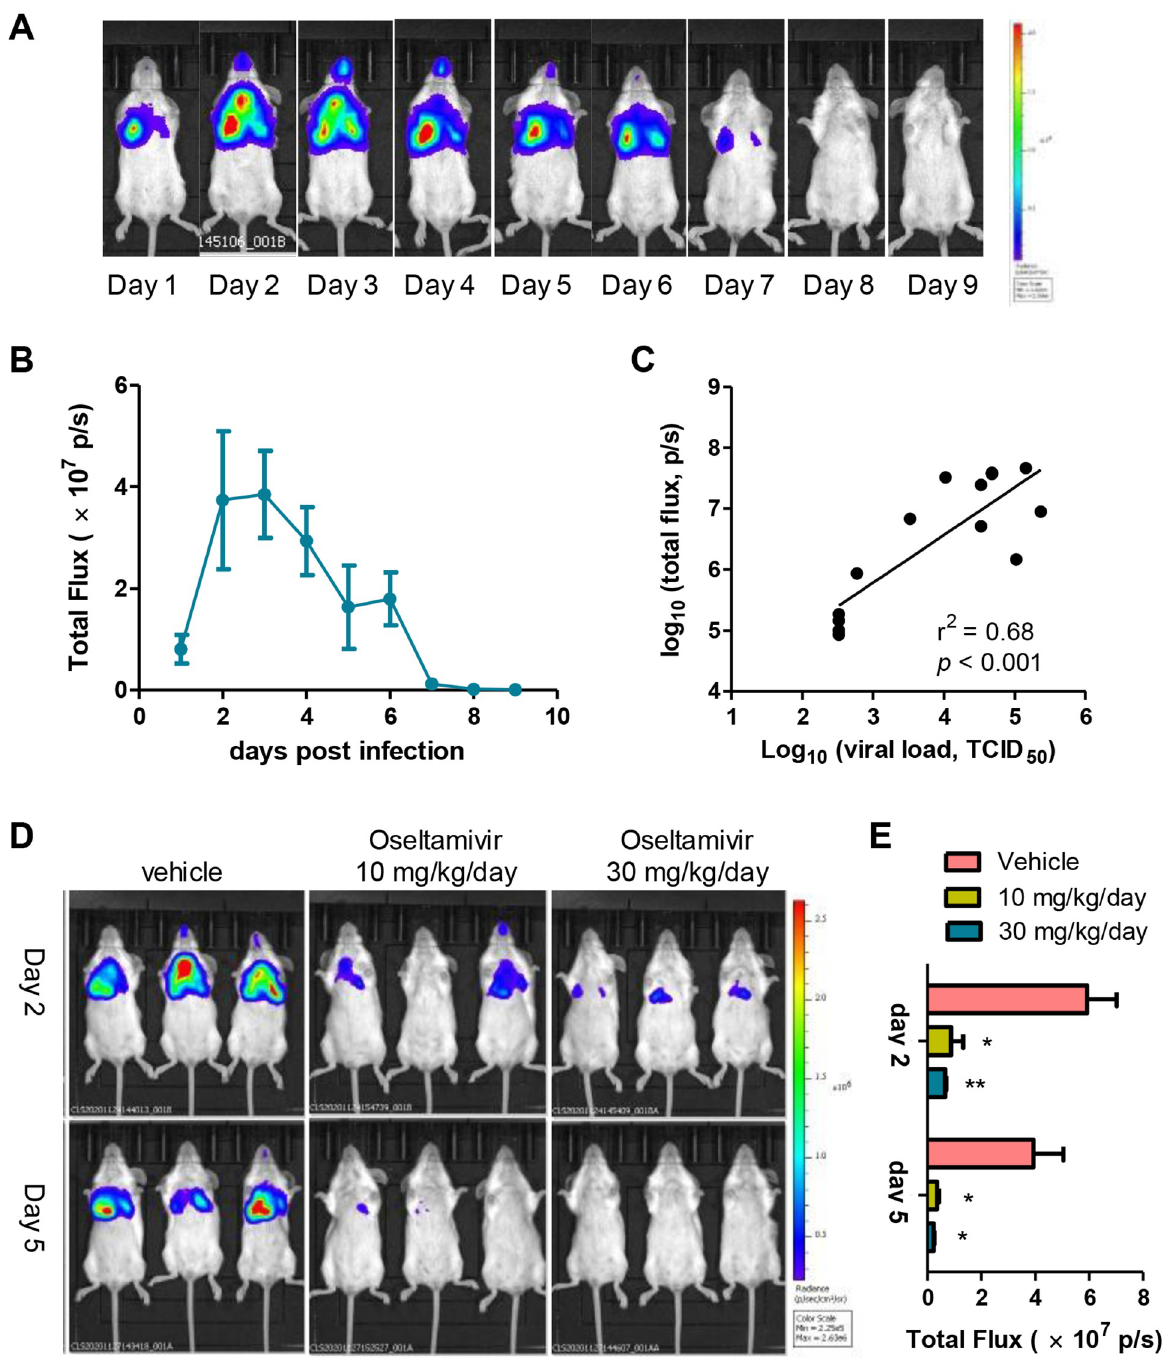
Fig 5. Establishment of an in vivo imaging mouse model of IAV infection. (A) Mice were infected with 1,000 TCID 50 of PR8-NS CE2 -Fluc virus and the bioluminescence was monitored daily for 9 days. (B) Bioluminescence imaging data corresponding to the time course of PR8-NS CE2 -Fluc infection. (C) In a separate experiment, in vivo imaging was performed and mice were then euthanized for determination of viral load in lungs. The bioluminescence density and viral load from individual animals were plotted against each other from time courses of PR8-NS CE2 -Fluc infection. (D) PR8-NS CE2 -Fluc infected mice were treated with 10–30 mg/kg/day of oseltamivir phosphate or vehicle only, and the in vivo imaging was carried out on days 2 and 5. (E) Data correspond to the in vivo imaging. � , p < 0.05; �� , p < 0.01; students’ t test.